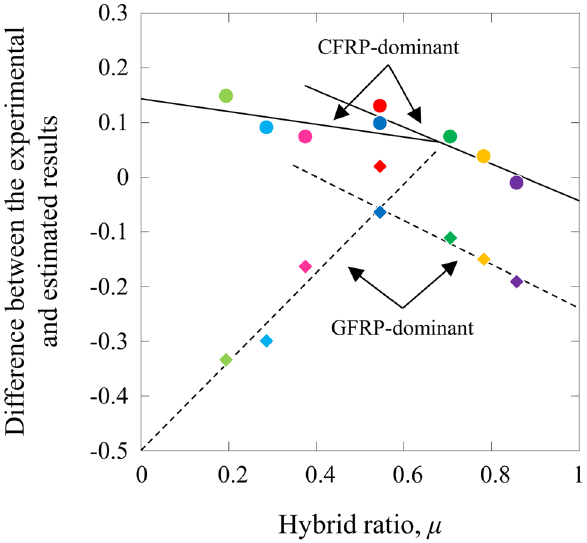
Figure 7. Difference between the experimental and estimated results as a function of the hybrid